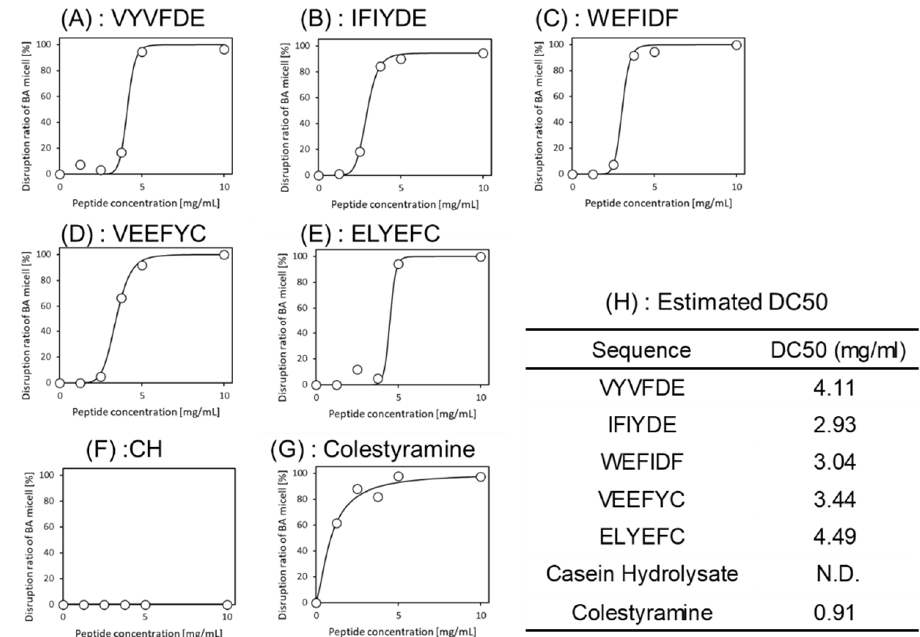
Figure 3. Dose-response curves of the peptides for micelle disruption activity. ( A ) VYVFDE, ( B ) IFIYDE, ( C ) WEFIDF,